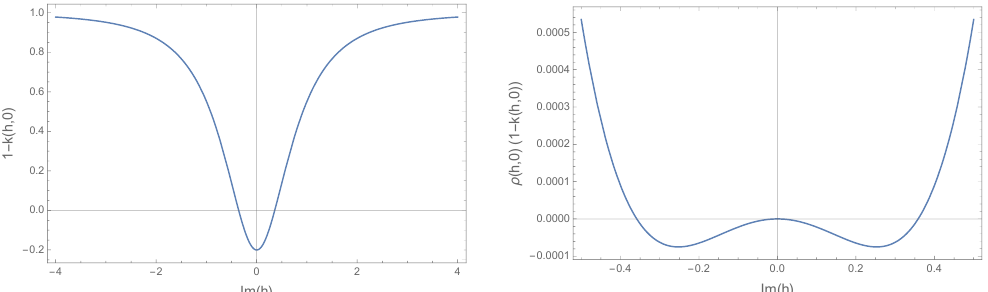
and x exchanged. 3 4